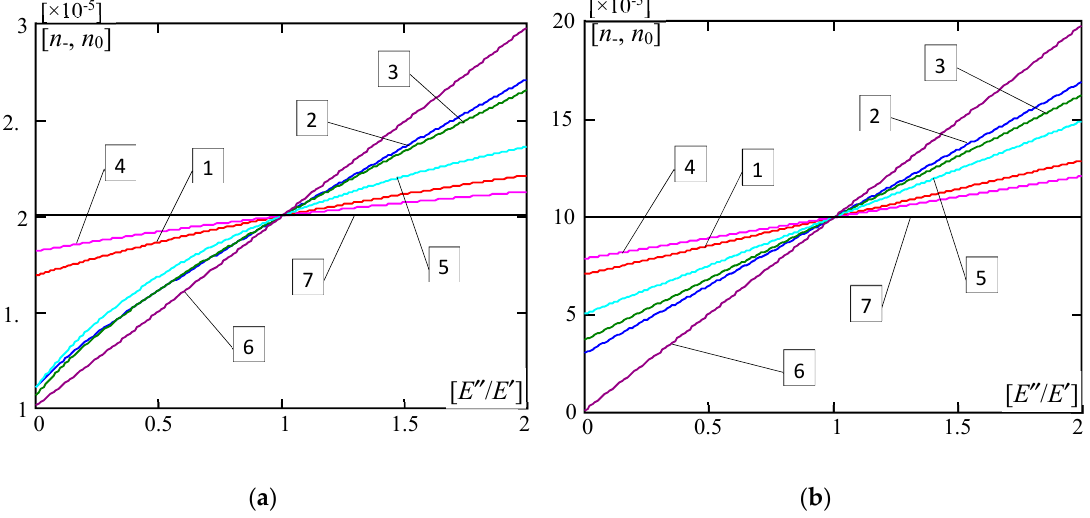
Figure 10. Values of dimensionless parameters n _ , n 0 of critical forces versus the ratio E ′′ / E ′ ( l / L = 0.02, m = 1): ( a ) d / L = 0.01, κ = 10 − 6 ; ( b ) d / L = 0.001, κ = 10 − 4 . (1 — γ by (28) 1 , 2 — γ by (28) 2 , 3 — γ by (28) 3 , 4 — γ by (28) 4 , 5 — γ by (29)).